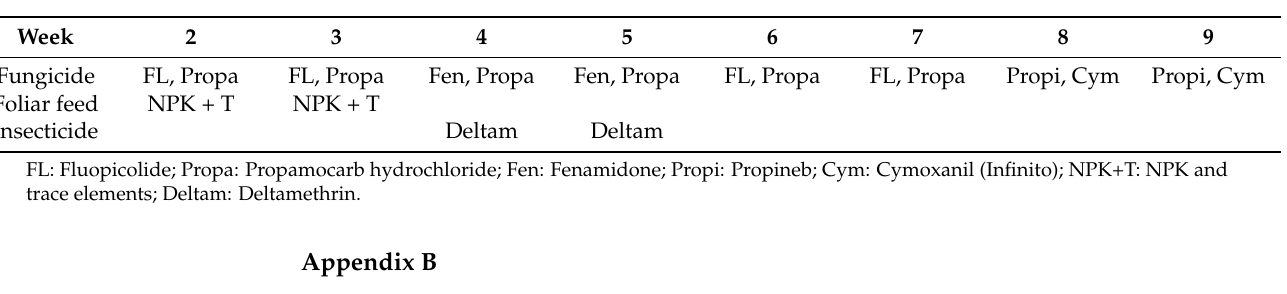
Table A1. Spray regime in scenario 4 [14]: it lasts for 8 weeks starting 2 weeks after emergence of the disease.